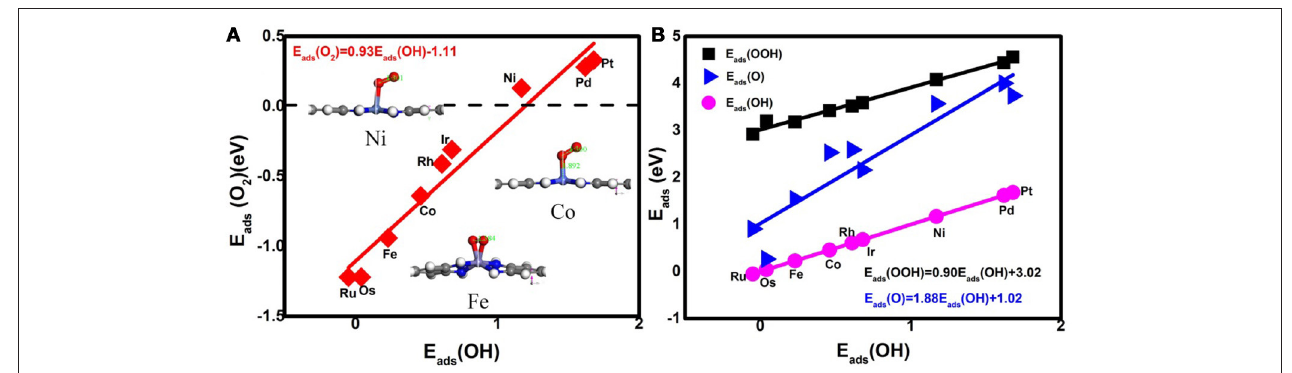
FIGURE 2 | The adsorption energies of the O 2 molecules (A) and the ORR intermediates (B) . Inset: the representative O 2 adsorption structure on Ni, Co, and Fe active